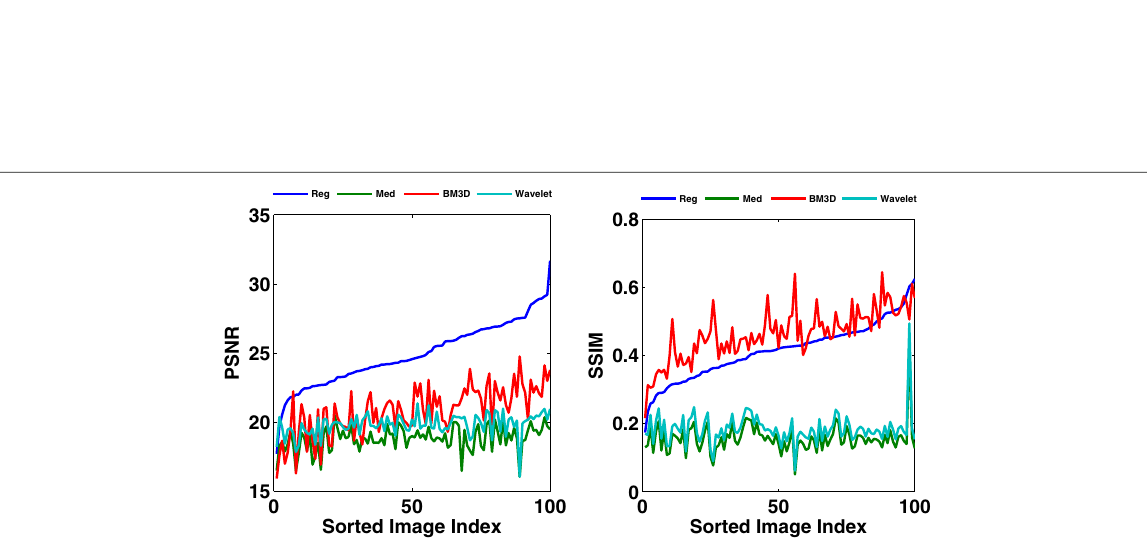
Fig. 15 One-hundred sample images denoised using our L 2 regression filter, median, BM3D, and wavelet filters with Gaussian noise σ =